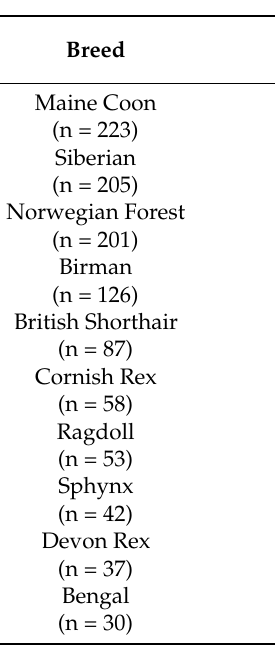
Figure 3. Illustration of numbers of BS-FCM performed per cat that developed FCM at any time- point, regardless of the previous screen result. BS-FCM = Breed-screened for FCM. FCM = feline cardiomyopathy. Table 4. Summary statistics of sex for the 104 cats that developed feline cardiomyopathy at any time-point by breed, with regards to the 1113 cats included in the study.